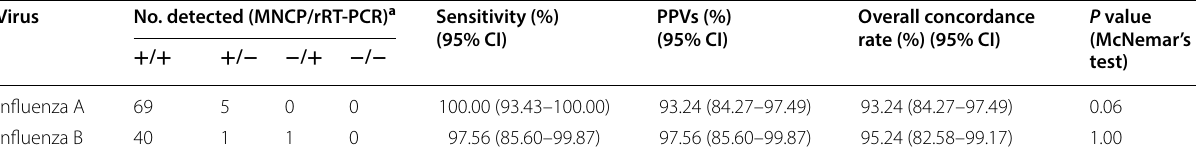
: positive; : negative; MNCP: micro/nanofluidic chip platform; rRT-PCR: real-time reverse transcription polymerase chain reaction; CI: confidence interval; PPVs: + − positive predictive values a Of 266 samples, 74 and 42 samples had opposite results between MNCP and RIDT for influenza A and B virus detection, respectively